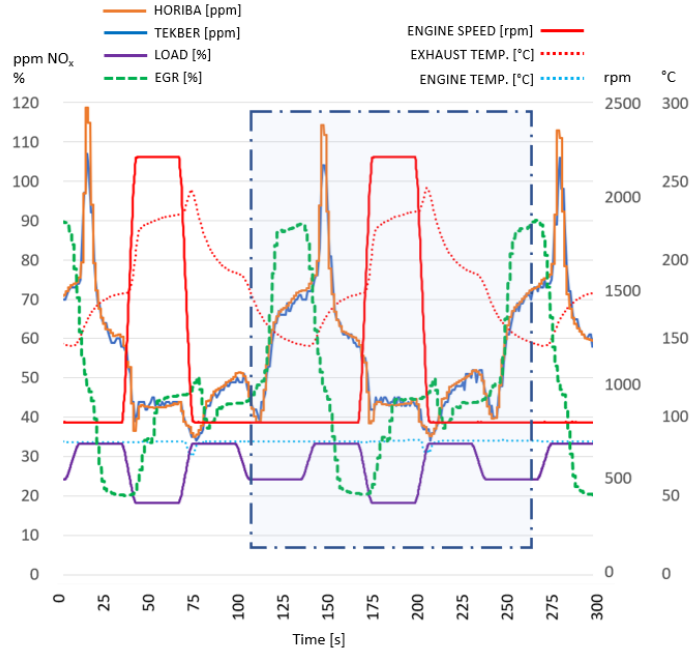
Figure 3 . Sample of the test with EGR and low load conditions. Figure 3. Sample of the test with EGR and low load